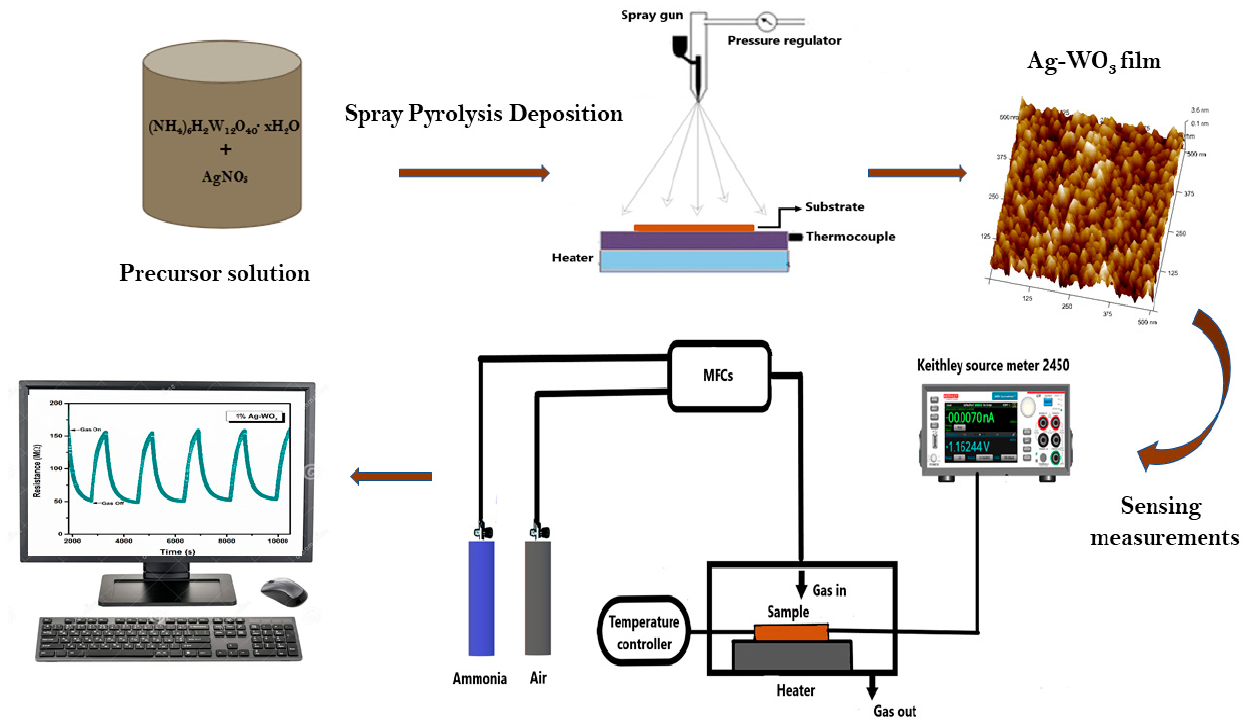
Figure 1. Schematic illustration of film deposition and ammonia sensing measurements of Ag–WO 3.